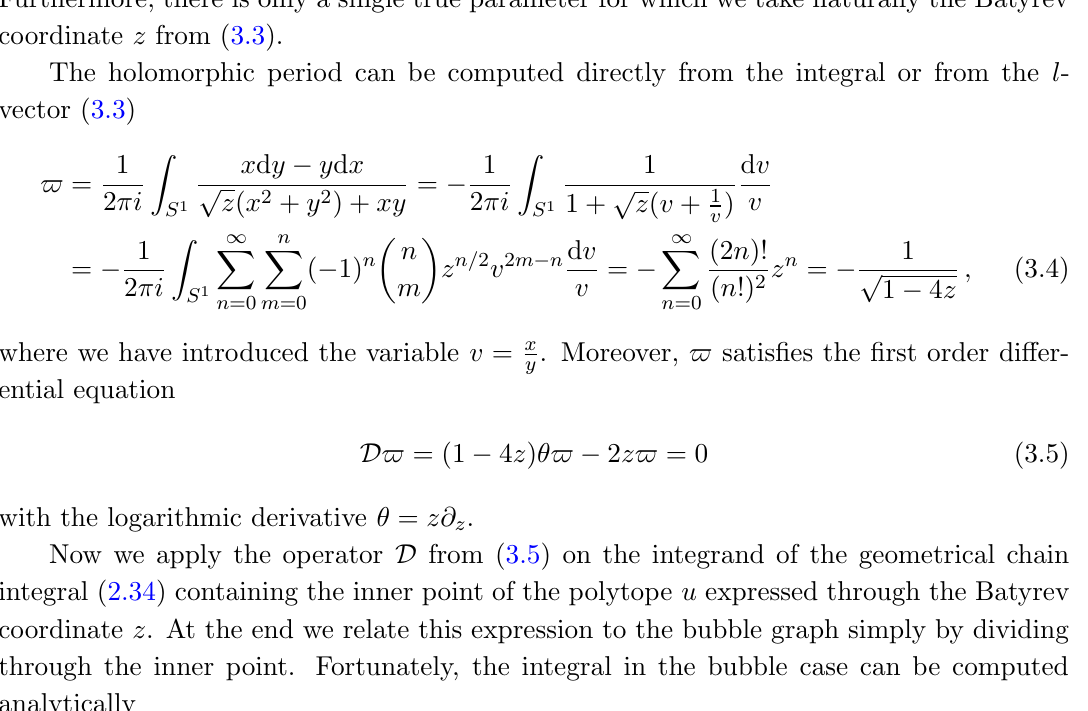
Figure 2 . The toric diagram for the bubble